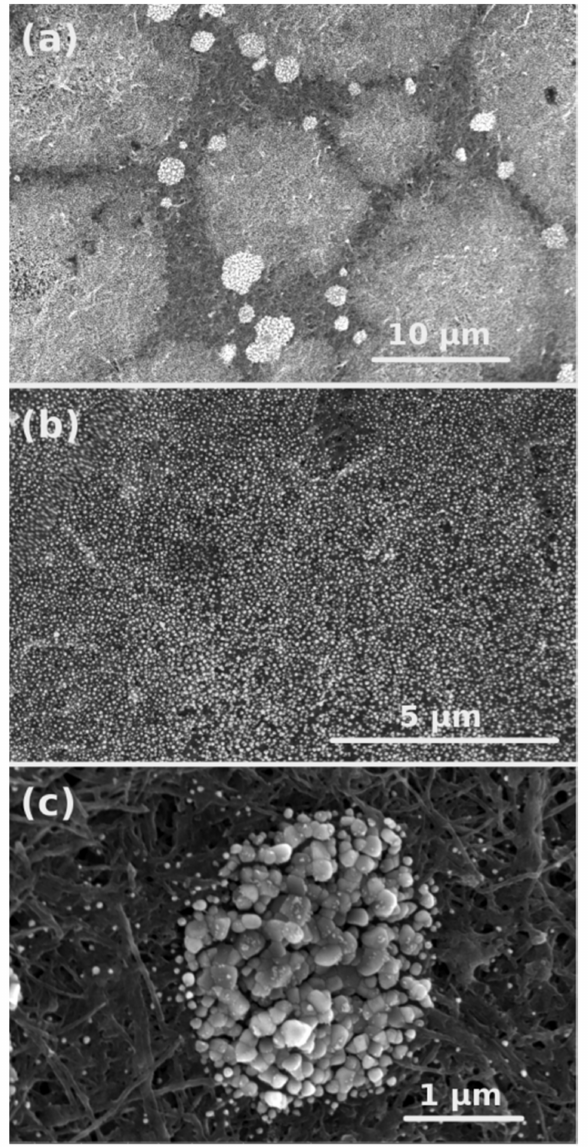
Figure 3. SEM images at various magnifications of Cu-CNT composites with two types of particles decorated onto carbon